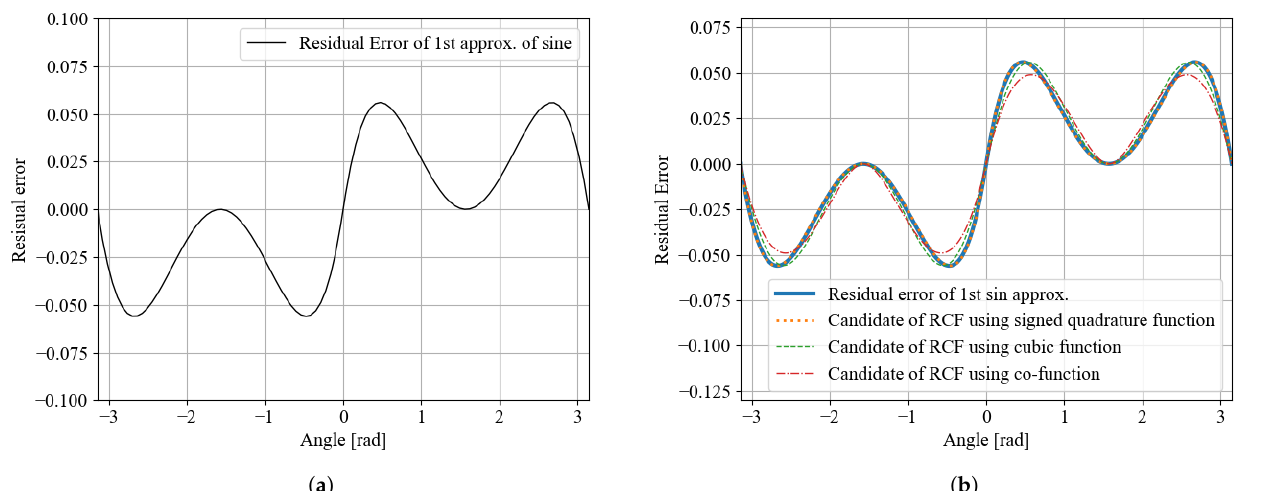
Figure 2. Residual error of 1st approximation of sin-function and candidates of its RCF. ( a ) Residual error of 1st approximation of sin function. ( b ) Comparison among designed RCFs.